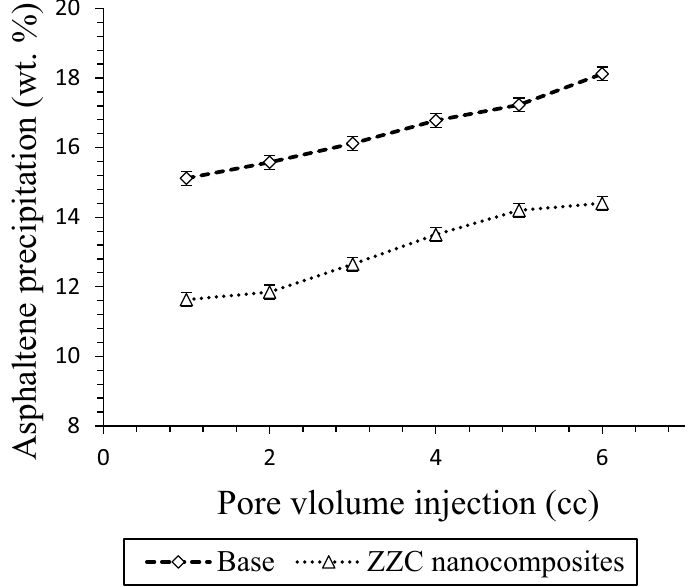
Figure 11. Effect of NCs on the asphaltene deposition during CO 2 flooding.